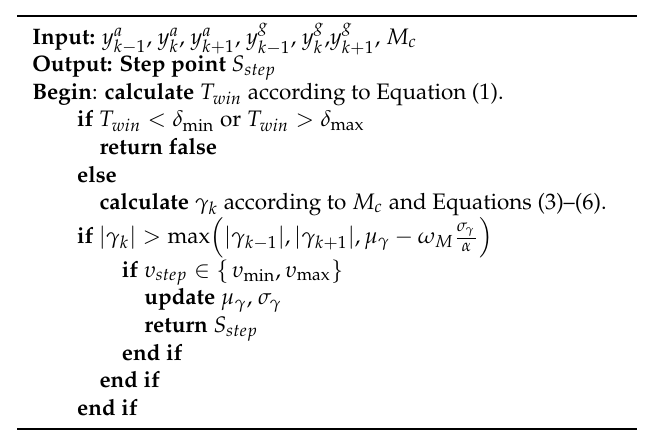
Table 2. Pseudocode of Step Detection